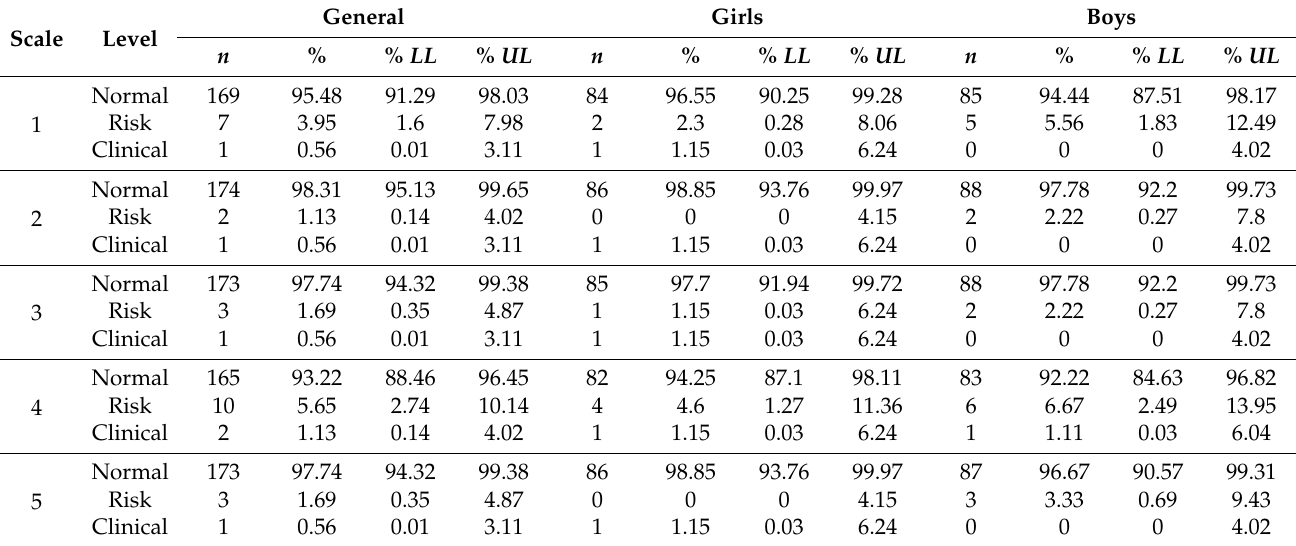
Table 4. Prevalence of DSM-oriented problems found through the